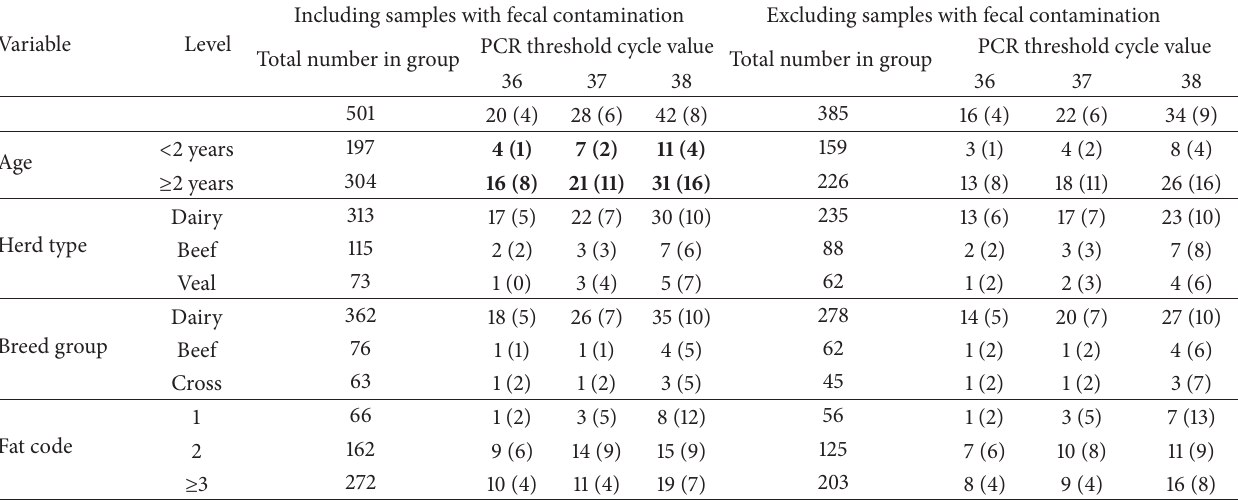
Table 1: Number and group specific percentage (in brackets) of muscle tissue samples from slaughtered cattle from which herd, breed type, and fat code. Positive results were defined in relation to possible fecal contamination to the tissue samples.